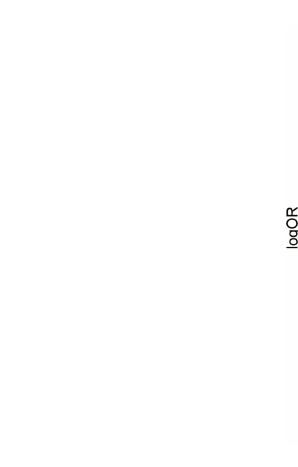
FIGURE 4 | Begg ’ s funnel plot of meta – analysis in the allele model (A vs. G).